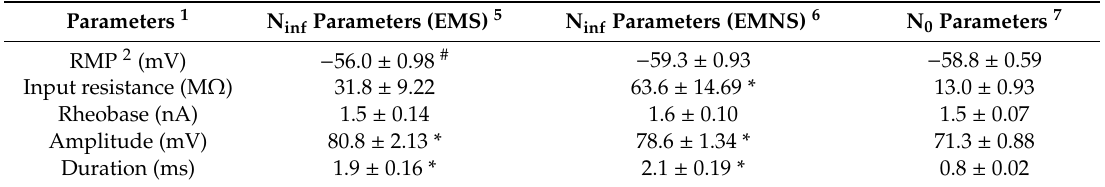
Table 1. Electrophysiological parameters of N inf (excitability melatonin sensitive (EMS) and excitability melatonin not sensitive (EMNS)) and N 0 neurons in control